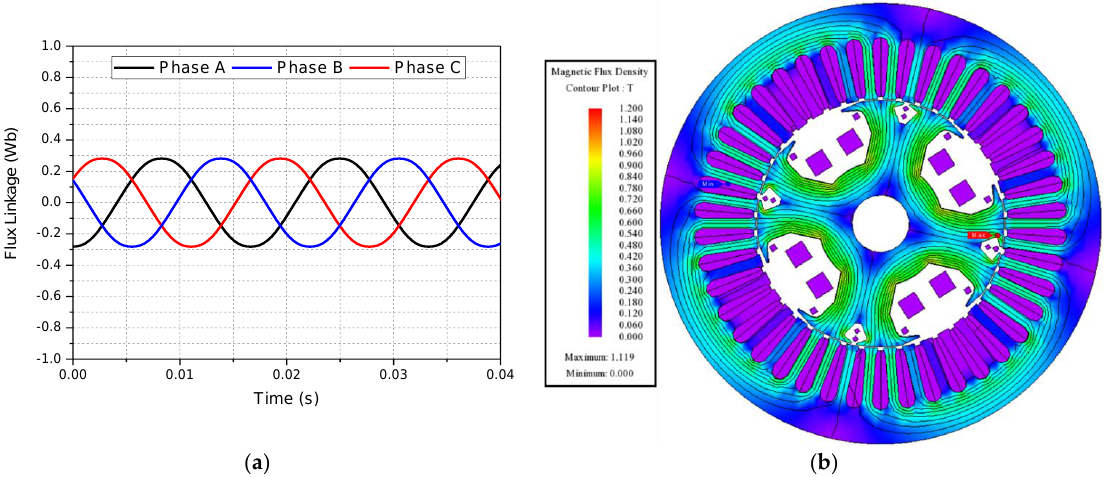
Figure 11. ( a ) Flux linkage and ( b ) magnetic flux density plot.